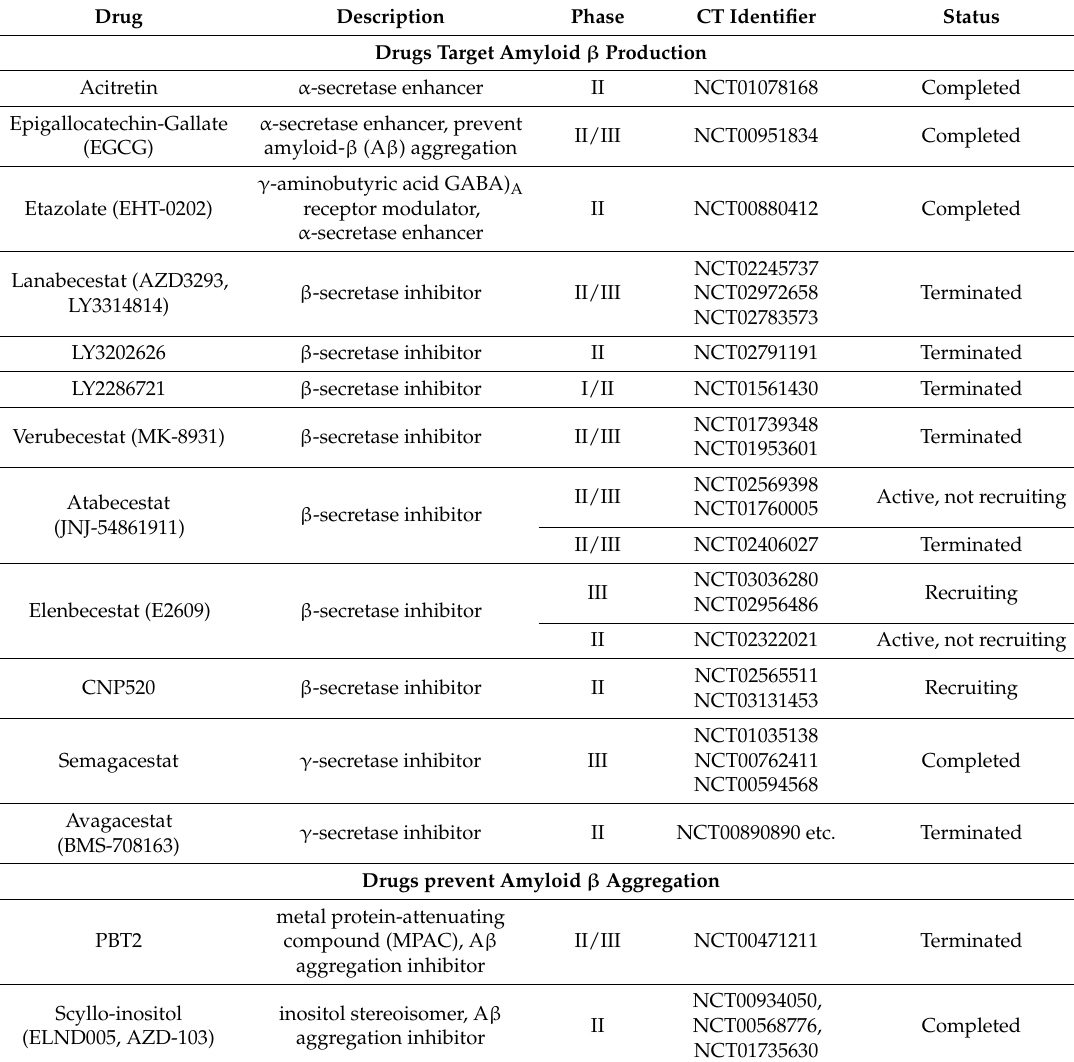
Table 1. Drug development for Alzheimer’s disease